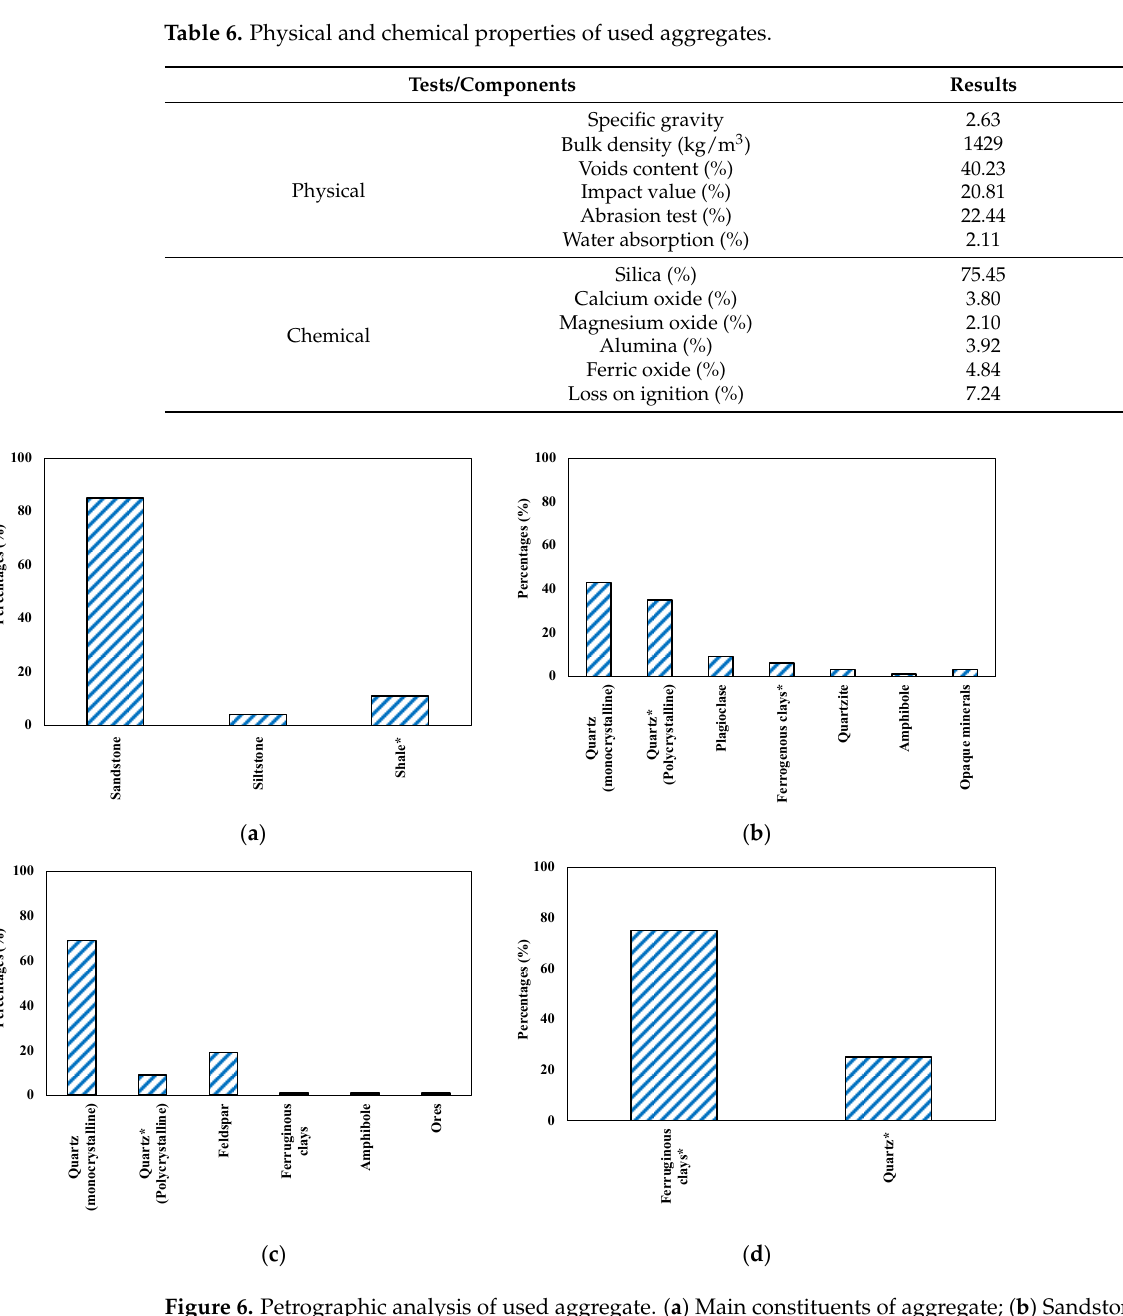
Figure 6. Petrographic analysis of used aggregate. ( a ) Main constituents of aggregate; ( b ) Sandstone; ( c ) Siltstone; ( d ) Shale (* indicate the reactive minerals).